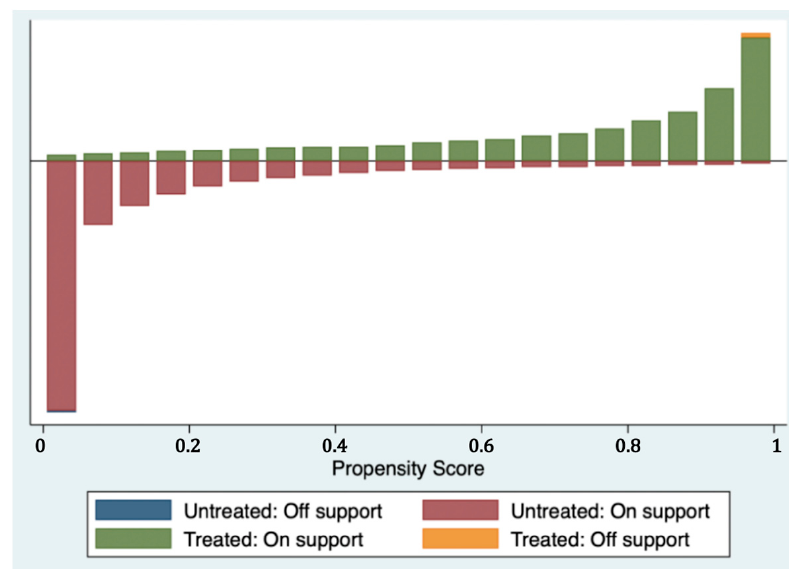
Figure 3. Common Range of Values for Propensity Score Matching.